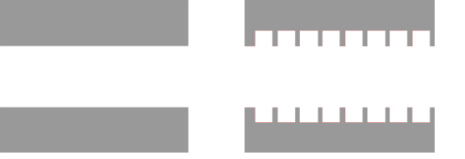
Figure 7. Collimator with smooth inner walls and collimator using collimation structures.